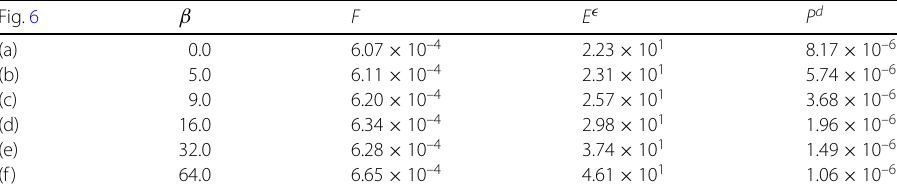
Table 2 Effect of the AMC for the MBB beam example Fig.